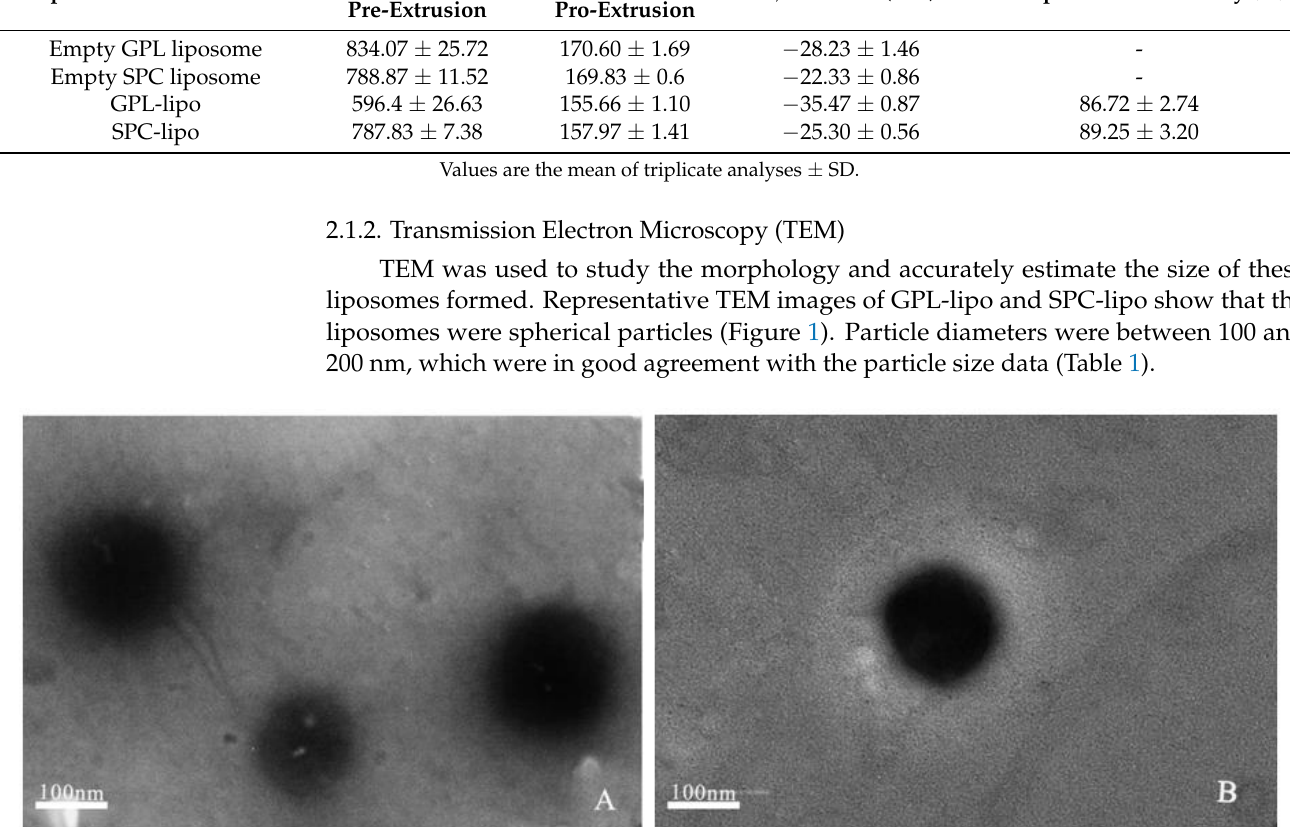
Table 1. Comparison of particle size, ζ -potential, and encapsulation efficiency of two CUR liposomes. Liposomes Formulations